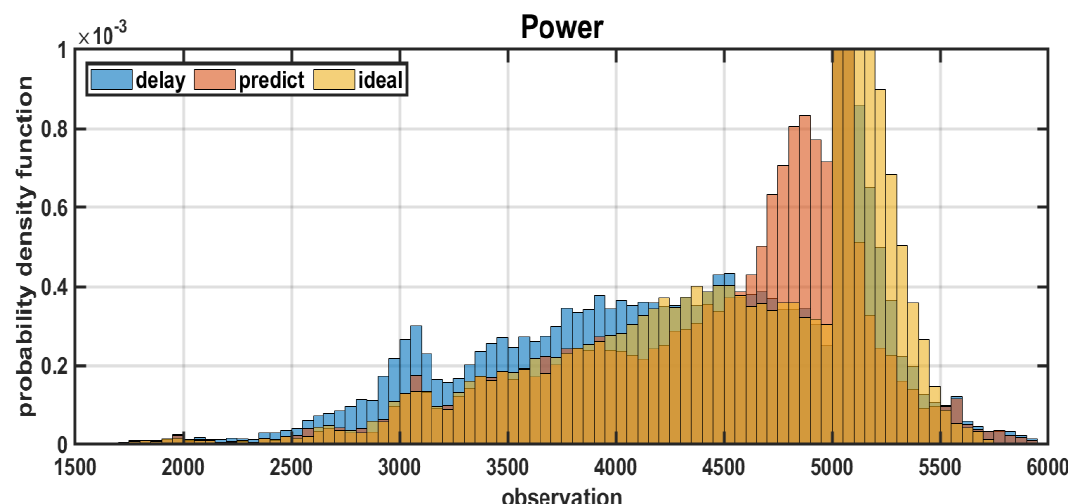
Figure 13. Histogram of output power of floating offshore wind turbine by pitch controller.